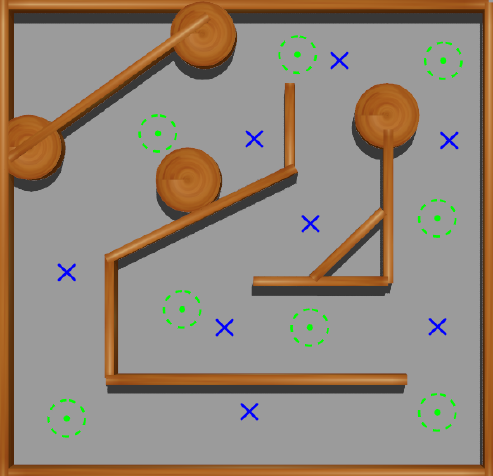
Figure 12. Top view of the training environment for the first and second stages. Possible initial and goal points are marked with blue crosses and green dots, respectively.